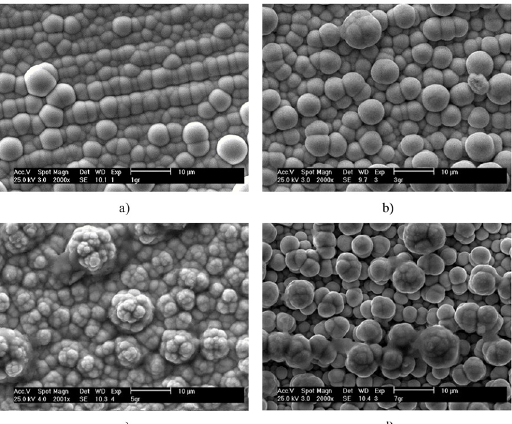
Figure 7. SEM micrographs of Ni-P-Cu coatings and composite coatings of Ni-P-Cu with different concentration of Cu particles, a) 1(gr/lit) Cu, b) 3 (gr/lit) Cu, c) 5 (gr/lit) Cu, d) 7 (gr/lit) Cu.